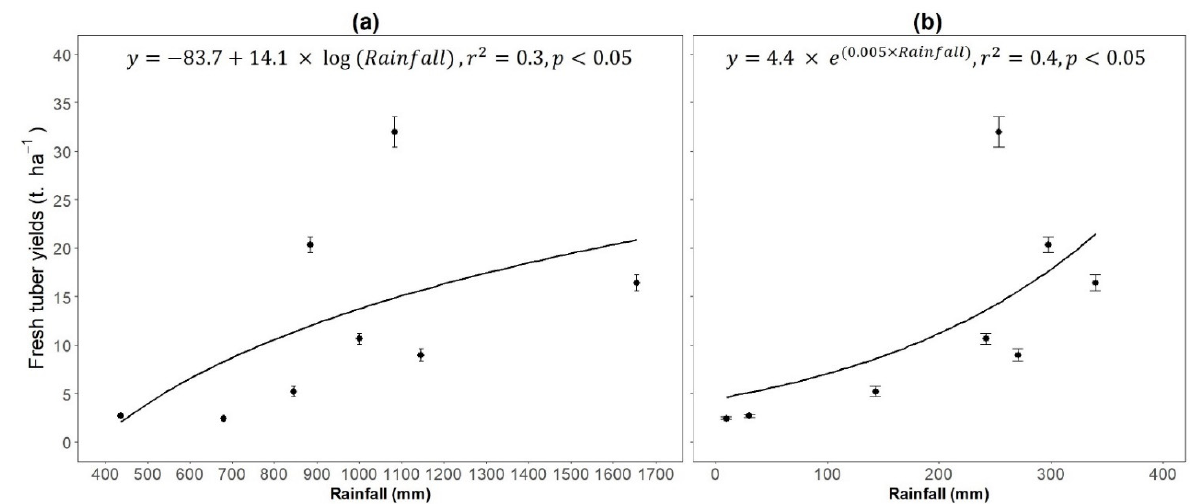
Figure 4. Relationships between the amounts of rainfall and water yam fresh tuber yields measured in 2016 and 2018 in Liliyo and Tiéningboué (Côte d’Ivoire), and Midebdo and Léo (Burkina Faso): ( a ) total amounts of rainfall recorded during the growing period of yam; ( b ) total amounts of rainfall recorded from tuber initiation at 112 DAP to maximum canopy development (MCD) at 140 DAP. In 2018, yam variety C18 was cultivated in the four sites after either a cereal, a legume, or a yam for each fertilization regime. The regression equations, the coefficients of determination, and the p-values are shown on the graphs. For the fresh tuber yields, each point represents a mean of 48 replicates. The fertilization regimes are: NON (no fertilization), MIN (sole mineral fertilization as NPK), MINORG combined organic and mineral fertilization), and ORG (sole organic fertilization as manure). A positive relationship was found between water yam fresh tuber yields and soil carbon stocks, considering data from the four sites and two years (Figure 5). The rainfall use efficiency ( RUE ) of water yam in 2016 and 2018 is presented in Table S13. The RUE of the four sites and two years were significantly positively correlated to soil carbon stocks (Figure S5).